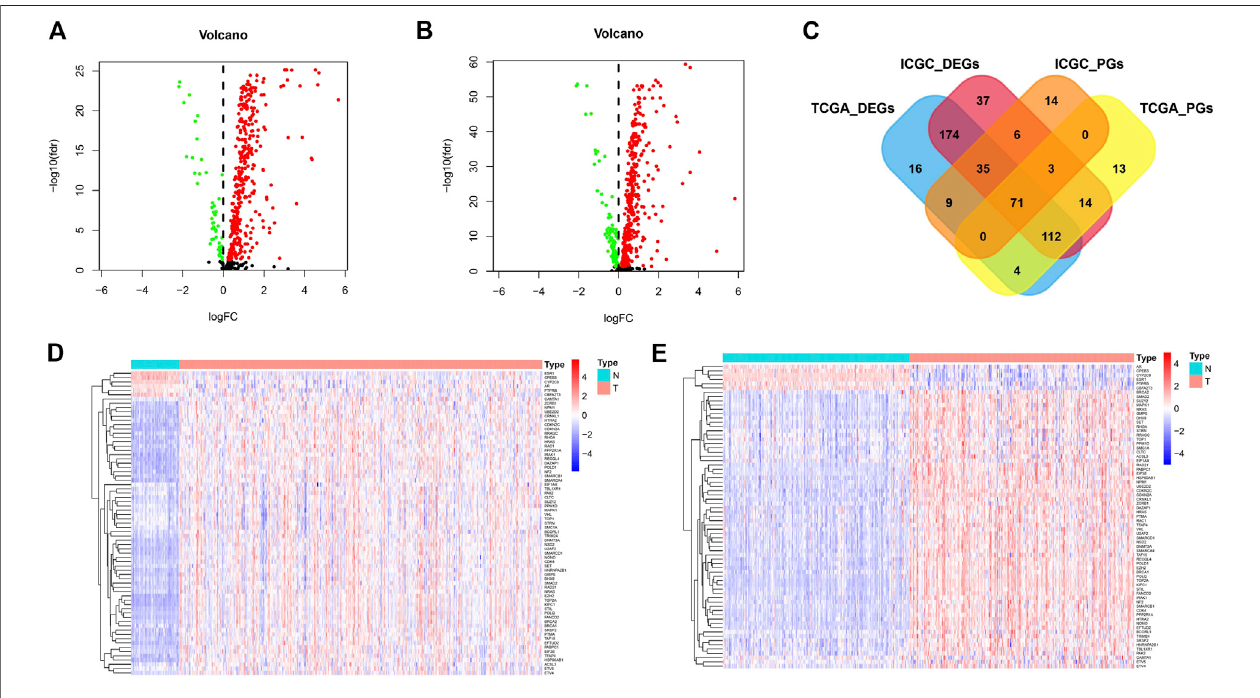
FIGURE1| Thedifferentiallyexpressed and prognostic genesinTCGA cohortand ICGCcohort. (A) Theexpressionofcancerdrivergenesbetweentumor tissues and paracancerous tissues in TCGA cohort. (B) The expression of cancer driver genes between tumor tissues and paracancerous tissues in ICGC cohort. (C) Venn diagrams for differentially expressed and prognostic genes. (D) The expression distribution of screened cancer driver genes in TCGA cohort. (E) The expression distribution of screened cancer driver genes in ICGC cohort.